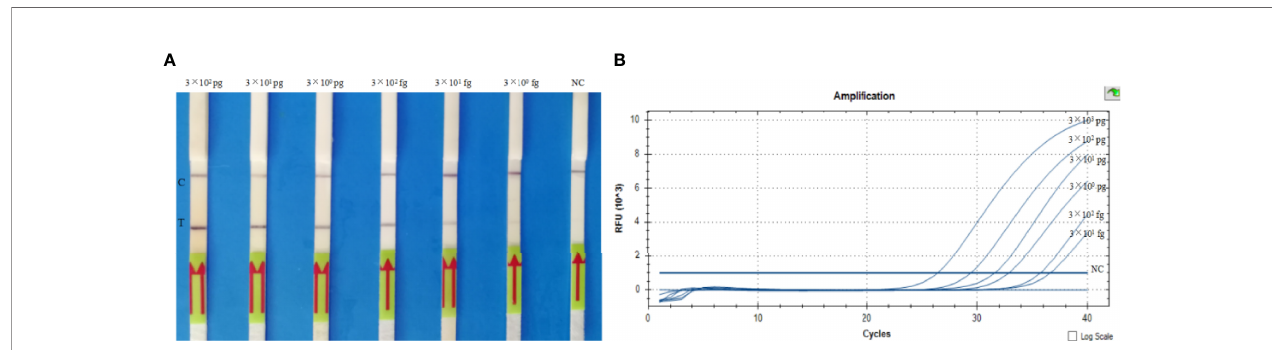
FIGURE 5 | Sensitivity of the LF-RPA assay (A) and real-time PCR assay (B) . (A) Analytical sensitivity of the LF-RPA assay based on the quantity of genomic DNA of B . pseudomallei BPC006, serially diluted gDNA of B . pseudomallei (300 pg, 30 pg, 3 pg, 300 fg, 30 fg, 3 fg per reaction) was tested by LF-RPA at 40°C for 10 min. (B) Analytical sensitivity of the real-time PCR assay based on the quantity of genomic DNA of B . pseudomallei BPC006, serially diluted gDNA of B . pseudomallei (3 ng, 300 pg, 30 pg, 3 pg, 300 fg, 30 fg per reaction) was tested by real-time PCR at 95°C for 5 min, followed by 40 cycles of 95°C for 10 seconds and 60°C for 30 seconds. NC, negative control; C, control line; T, test line. This experiment was repeated three times with the same result.